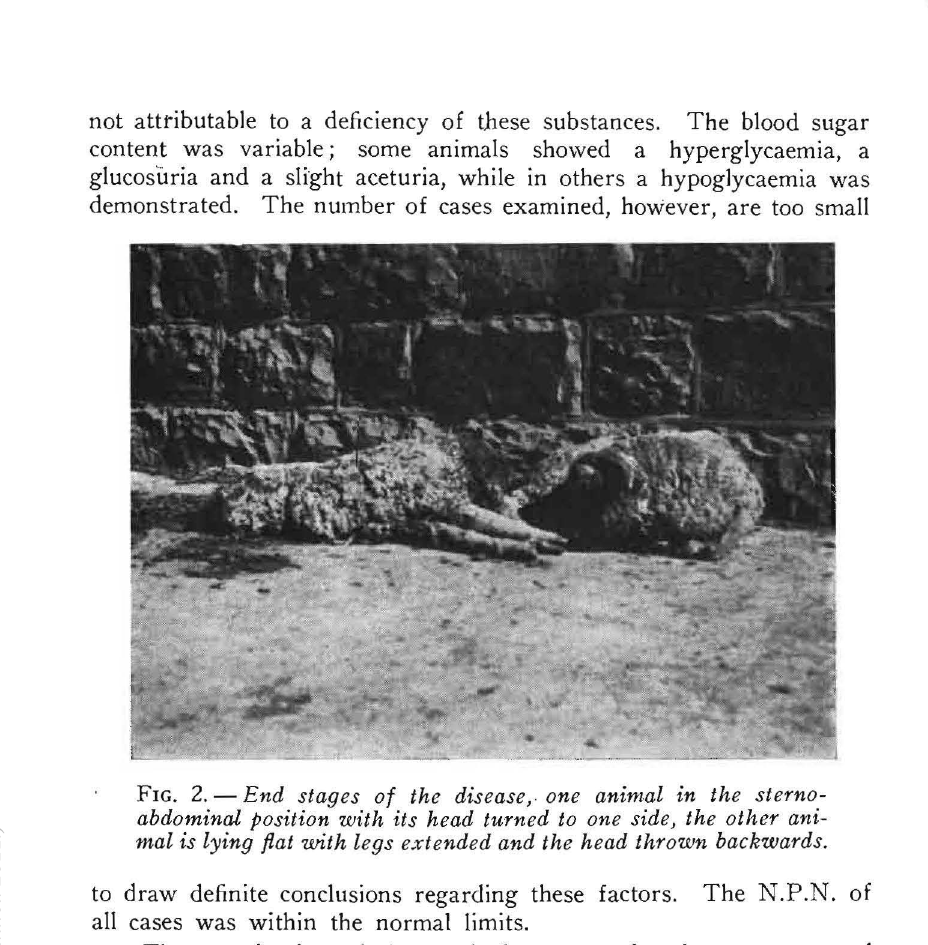
FIG. 2. - End stages of the disease, one animal in the sterno abdominal position with its head turned to one side, the other ani mal is lying fiat with legs extended and the head thrown